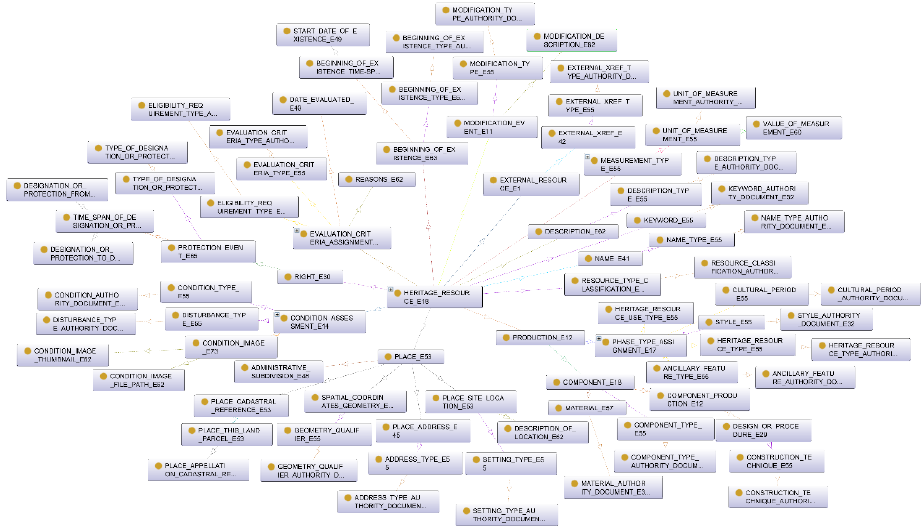
Figure 4. Ontology model of historic site